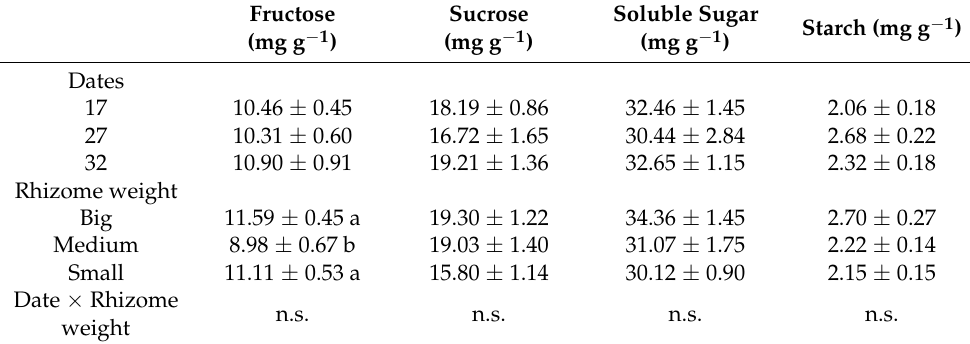
Table 4. The fructose, sucrose, soluble sugar and starch concentration in rhizomes on 17, 27 and 32 DAP in EXP.1. Data shown are Mean ± s.e. ( n = 3).